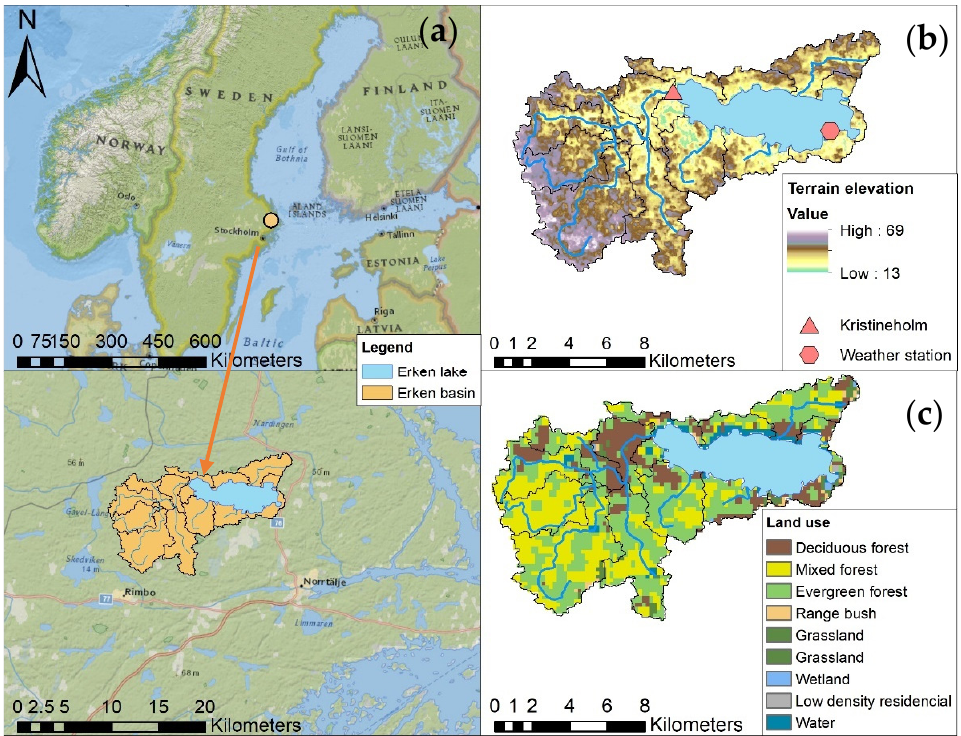
Figure 2. Map of the study area: ( a ) localisation of Lake Erken and its basin in the Scandinavian Peninsula; ( b ) digital elevation map of the Lake Erken basin and location of Kristineholm and the weather station; ( c ) land uses in the Lake Erken basin.